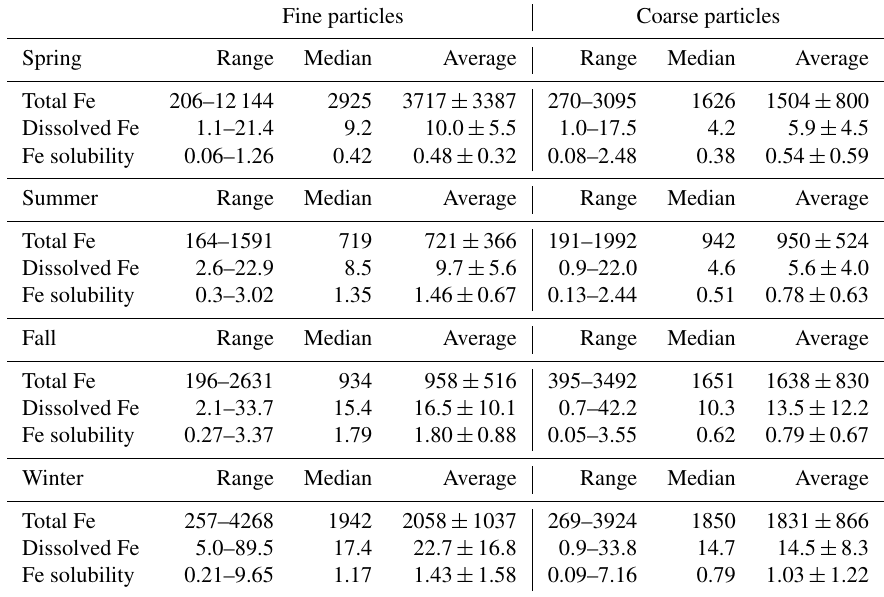
Table A1. Overview of total Fe (ngm − 3 ), dissolved Fe (ngm − 3 ) and Fe solubility (%) for fine and coarse particles in different seasons at